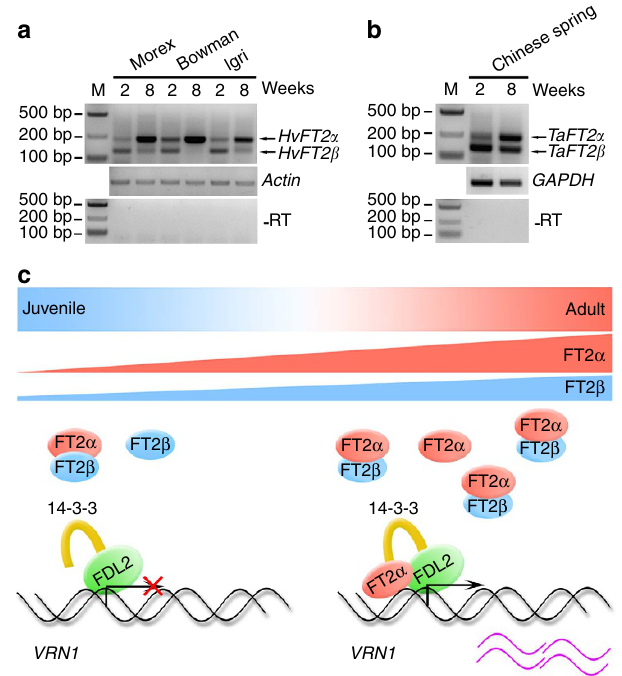
Figure 7 | Dynamic changesin FT2 AS with plant development is prevalent in barley and wheat. ( a ) RT-PCR analysis of FT2 a and FT2 b expression in barley with the indicated age. Primers designed for simultaneous amplification of FT2 a and FT2 b in a single PCR reaction were used. Total RNA from three typical varieties of barley was isolated for reverse transcription. M, marker. ( b ) RT-PCR analysis of FT2 a and FT2 b expression in wheat with different ages. Total RNA from Chinese Spring was isolated for reverse transcription. ( c ) A working model for two FT2 splicing isoforms during plant flowering-induction processes in temperate grasses. Although both two FT2 splicing transcripts increase along with plant development, their increasing rates are not consistent, resulting in distinct FT2 b / FT2 a ratio with different age. FT2 b and FT2 a can form heterodimers. Thus when plants are vegetative, the formation of flowering-induction complex is blocked, because FT2 b expression level is higher than that of FT2 a . When plants grow to reproductive stage, more FT2 a accumulates than FT2 b , and the flowering initiation complex can be formed in the SAM to induce VRN1 expression, ensuring eventual plant flowering at right growth FT2 and FT1 in B. distachyon are thought to have redundant roles on florigen activity because of their high amino-acid same early flowering phenotype if overproduced. Thus it seems